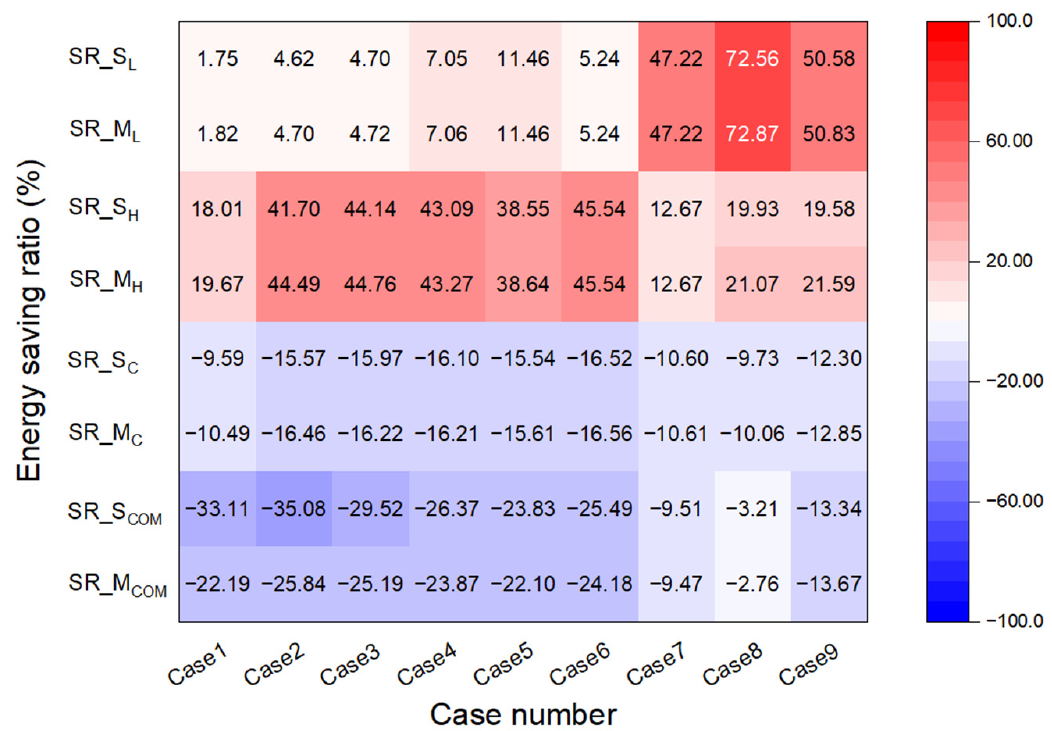
Figure 17. Energy saving analysis of building with different PVSDs in Guangzhou.